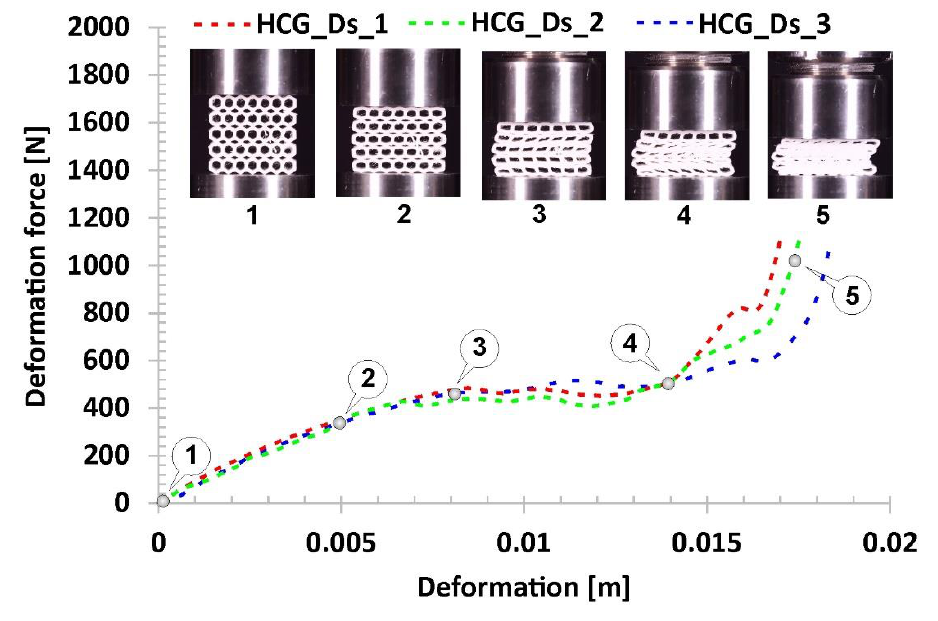
Figure 16. The results of the compression tests of the structural specimen with gradual discrete honeycomb topology.